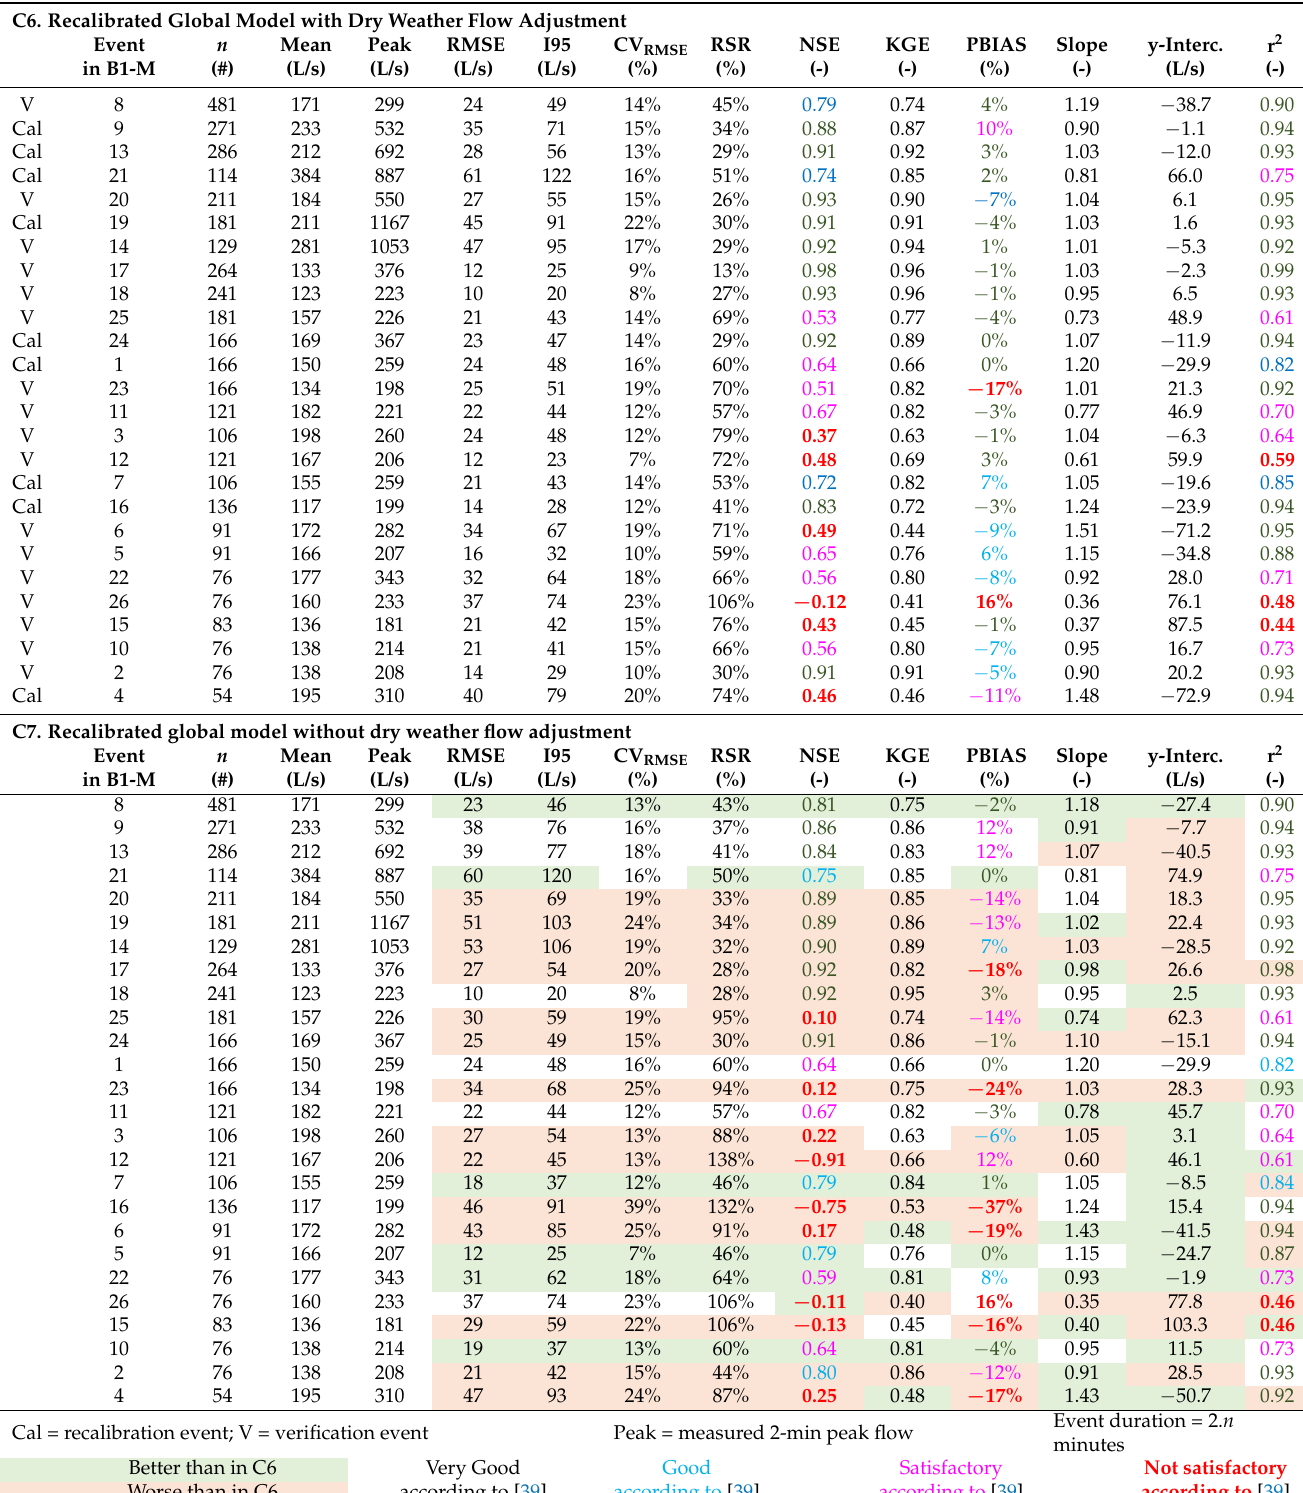
Table A2. Statistical results for all events in B1-M, for the recalibrated model with and without DWF